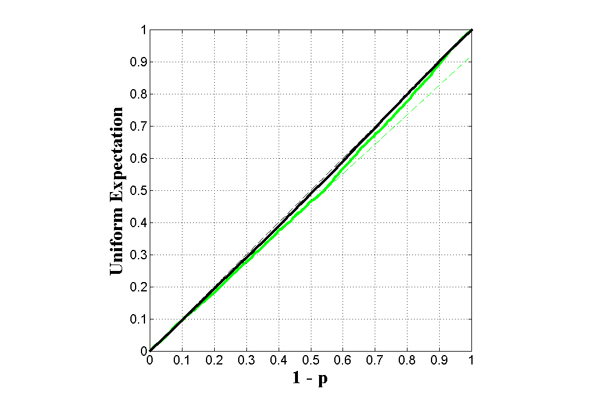
Cumulative frequency distribution of 1-p (p-value plot) for expressed genes and 'not expressed' genes. The distribution for expressed genes is green and the distribution for 'not expressed' genes is black. The p-values are from the t-tests of a gender difference. The dashed lines indicate a theoretical uniform distribution for p-values under the null hypothesis; the black line assumes that all of the 'not expressed' genes fit the null hypothesis and the green line assumes that 92% of expressed genes fit the null hypothesis.